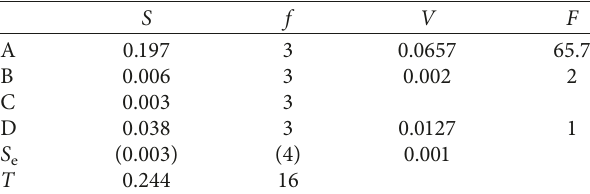
Table 8: Analysis table of variance data.